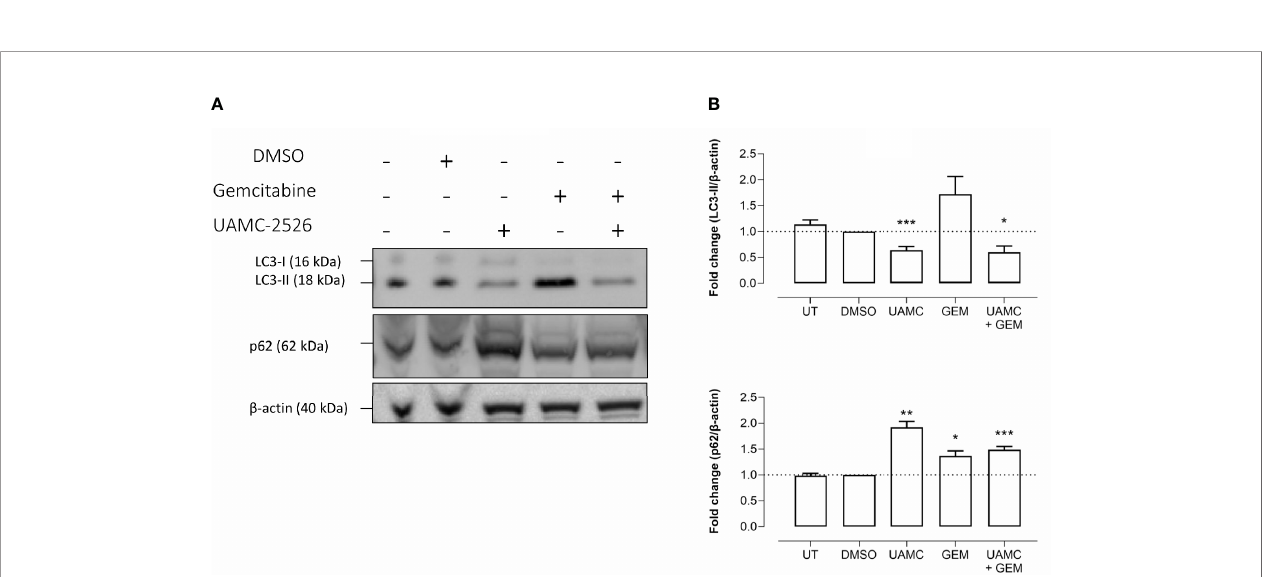
FIGURE 2 | UAMC-2526 inhibits LC3 processing in Panc02 cells. (A) Panc02 cells were treated in vitro with UAMC-2526 (UAMC, 10 µM) in the presence or absence of gemcitabine (GEM, 10 µM) for 32 hours. Western blots were performed for LC3-II and p62. b -actin served as a loading control. One representative blot (out of fi ve independent experiments) is shown. (B) Quanti fi cation of LC3-II and p62 relative to b -actin. Data were analyzed using one sample t-test. After normalization, the resulting fold change was log transformed (log2-base) to obtain an approximately normal distribution,*p ≤ 0.05, **p ≤ 0.01***p ≤ 0. 001, versus DMSO group. UT,